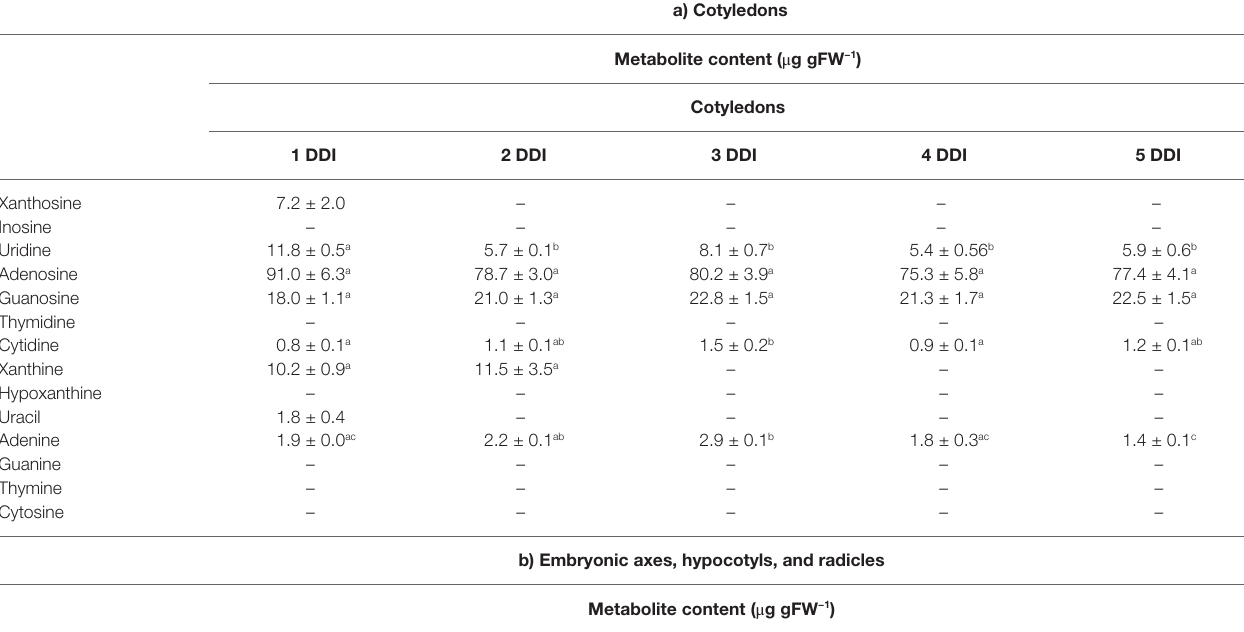
TABLE 3 | Nucleosides and nucleobases content in common bean